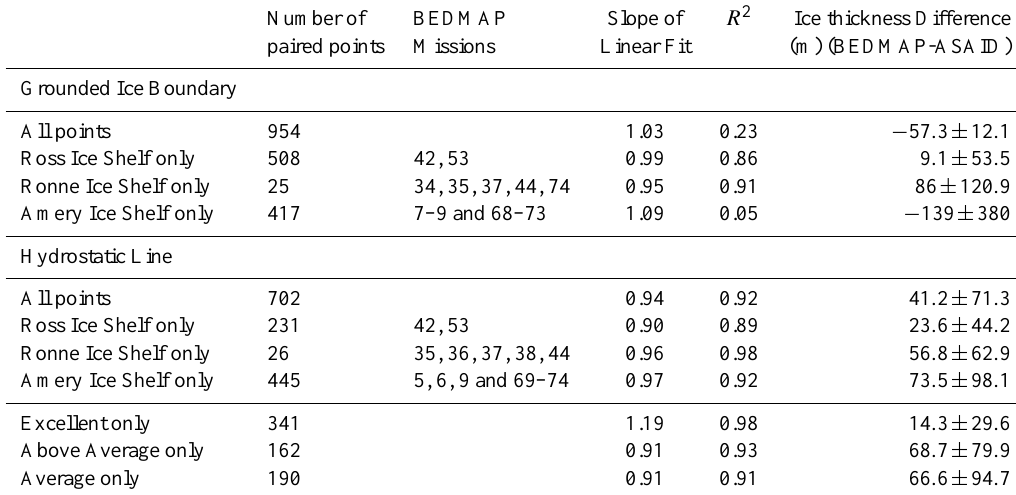
Table 5. Comparison of BEDMAP and ASAID Actual Ice Thicknesses. Slope and R 2 values refer to linear fits forced to pass through (0, 0) (cf., Figs. 11 and 12). BEDMAP mission numbers refer to the specific source data sets.